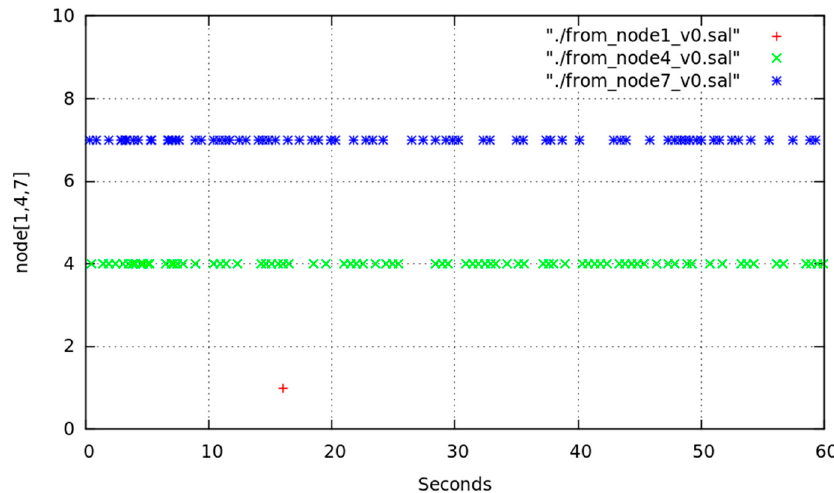
Figure 20. OLSR messages detected by node6.